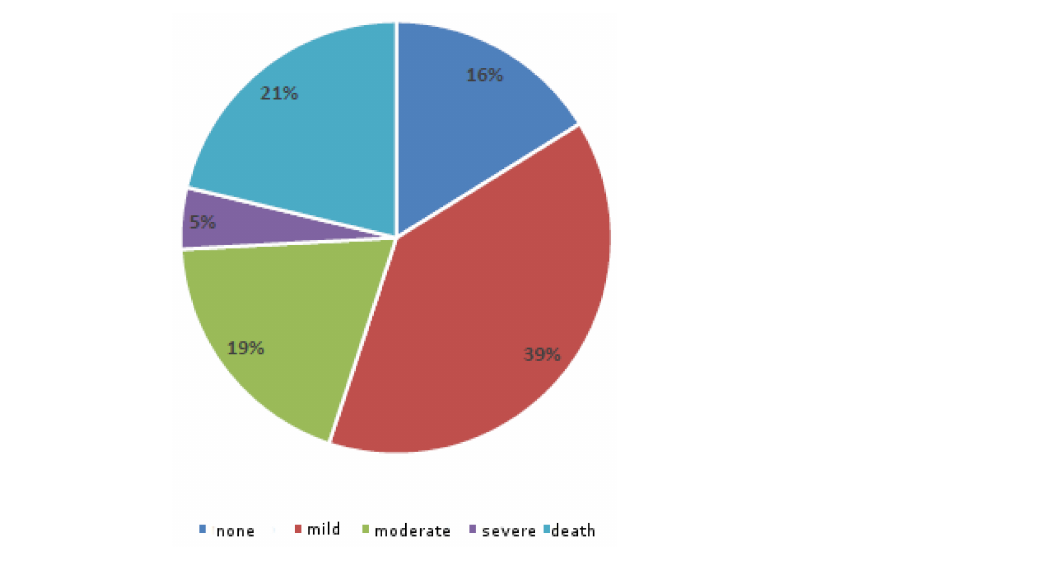
Figure 4. Patient outcome for claims (according to the International Classification for Patient Safety degree of